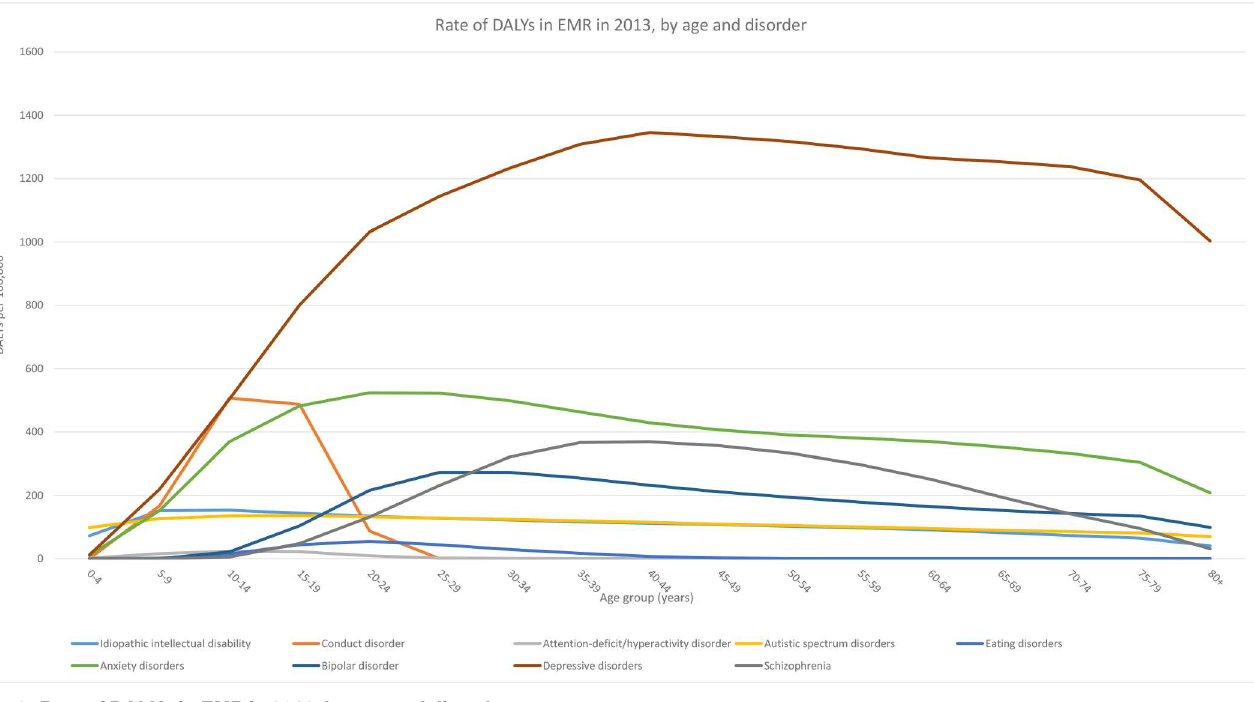
Fig 3. Rate of DALYs in EMR in 2013, by age and